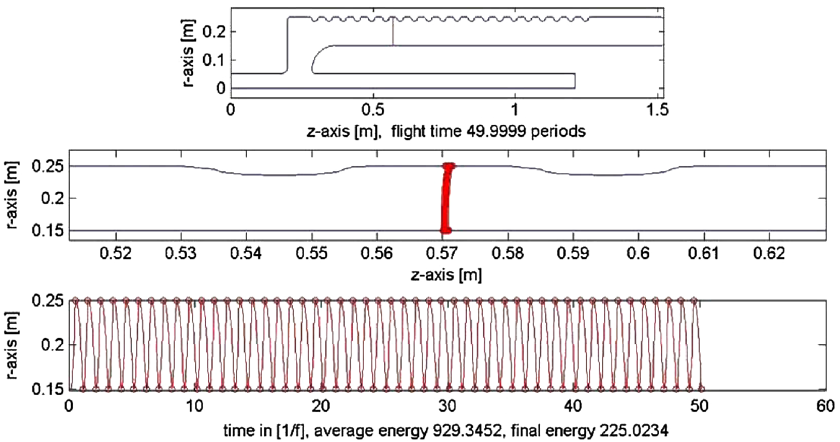
FIG. 12. (Color) Multipacting in the cavity when ripples point downwards.